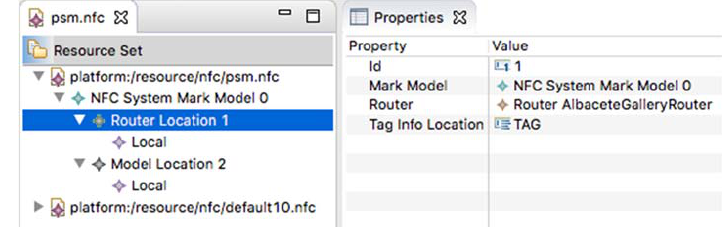
Figure 6. The Platform Specific Model of the Albacete photo gallery application.